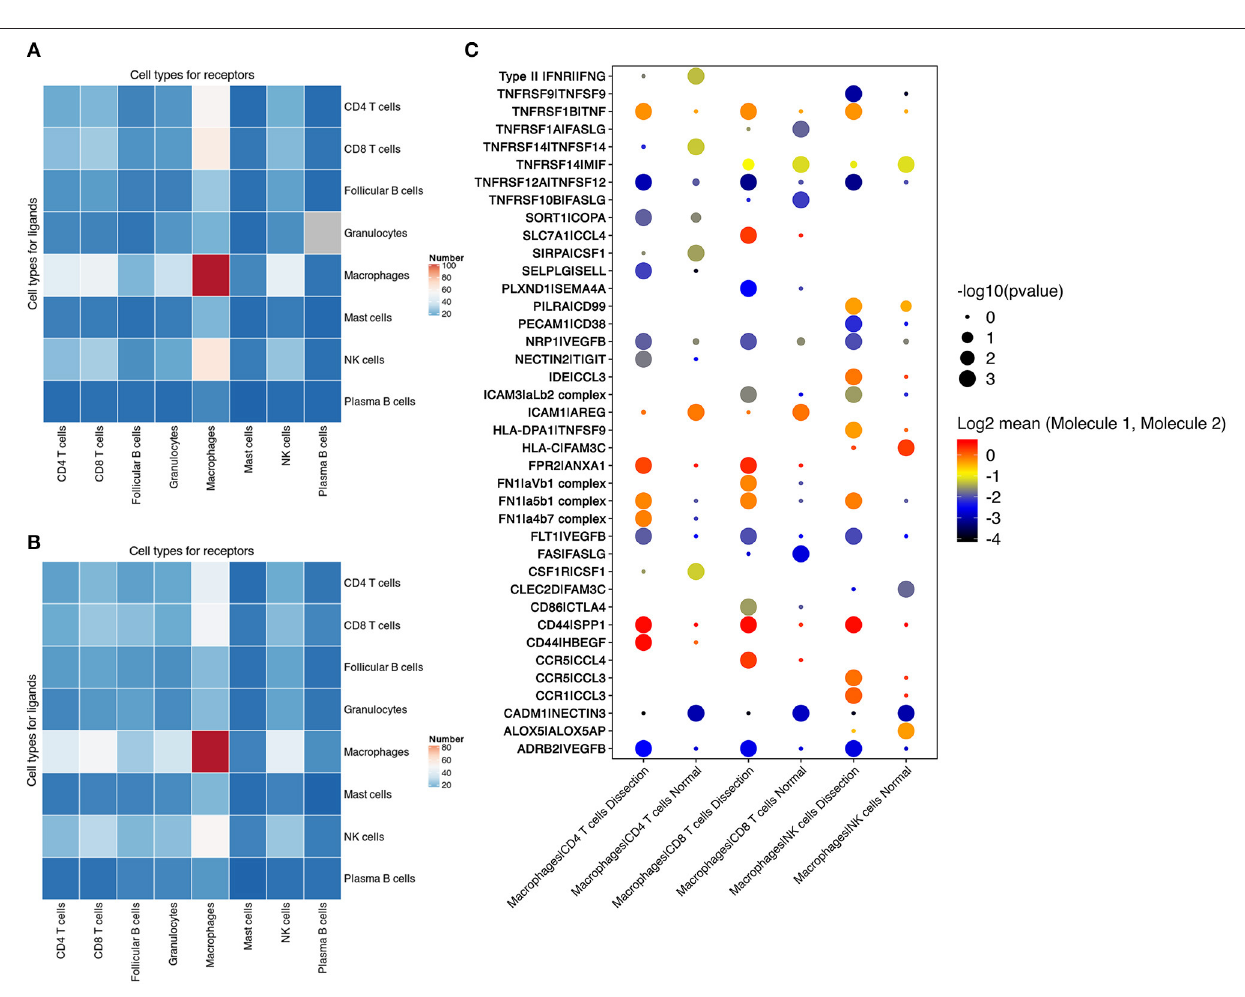
FIGURE 6 | Cell–cell communication between immune cells. (A,B) Number of predicted interactions ( P < 0.05) between macrophages, T cells, NK cells, B cells, neutrophils and mast cells based on CellPhoneDB in AD tissues (A) and normal aorta tissues (B) . (C) Selected ligand–receptor interactions between CD4 + T cells, CD8 + T cells, NK cells and macrophages, comparing the AD vs. NA group. AD, aortic dissection; NA, normal